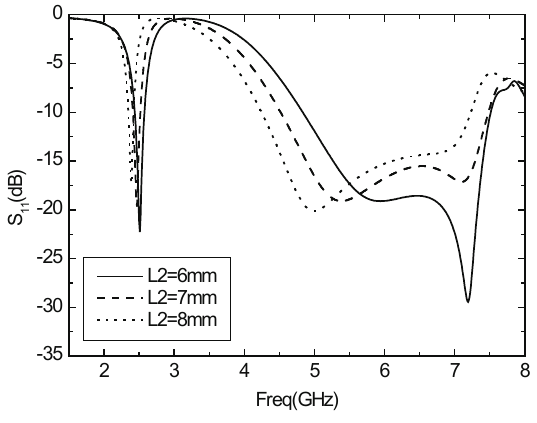
Figure 4. Parameter S 11 varies with